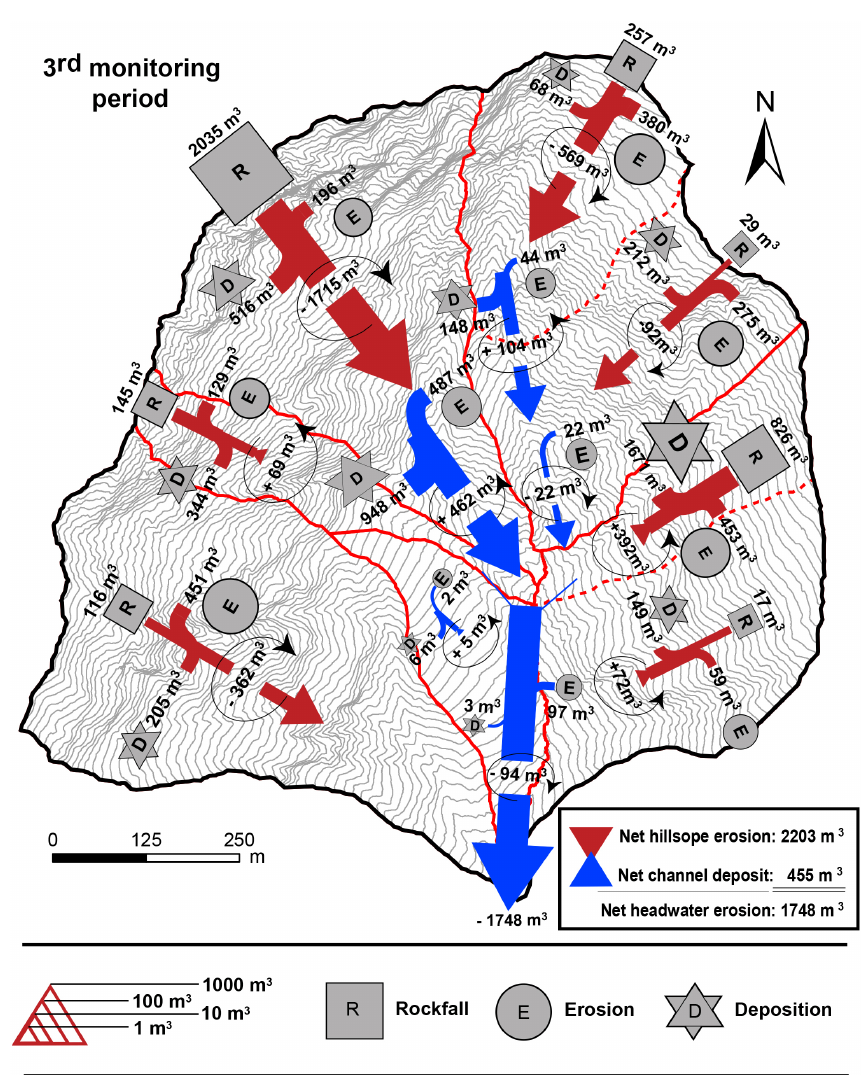
Figure 15. Overall headwater sediment budget observed during the third monitoring period revealing the sediment dynamics through the winter–spring and the net balance of sediment recharge in the downstream torrent for the period preceding the June 2010 debris